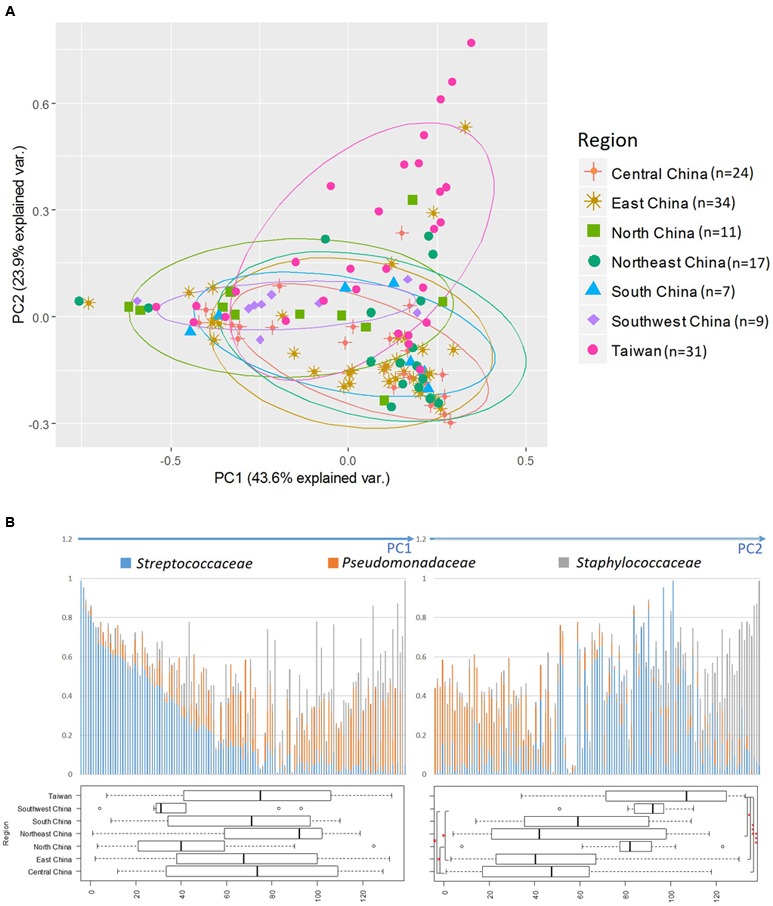
Principal component analysis (PCA) of bacterial abundance. (A) Principal component analysis (PCA) performed by using relative abundance data on all bacterial families. The three most abundant bacterial families are indicated by arrows and family names. (B) Distribution of the three predominant families in the 133 breast milk samples. The bacterial-composition data were sorted according to the PC1 score (left) and PC2 score (right). Variance among participants from each region is shown as a boxplot showing the smallest and largest values, 25% and 75% quartiles, the median, and outliers. ∗P < 0.05; ∗∗∗P < 0.001.